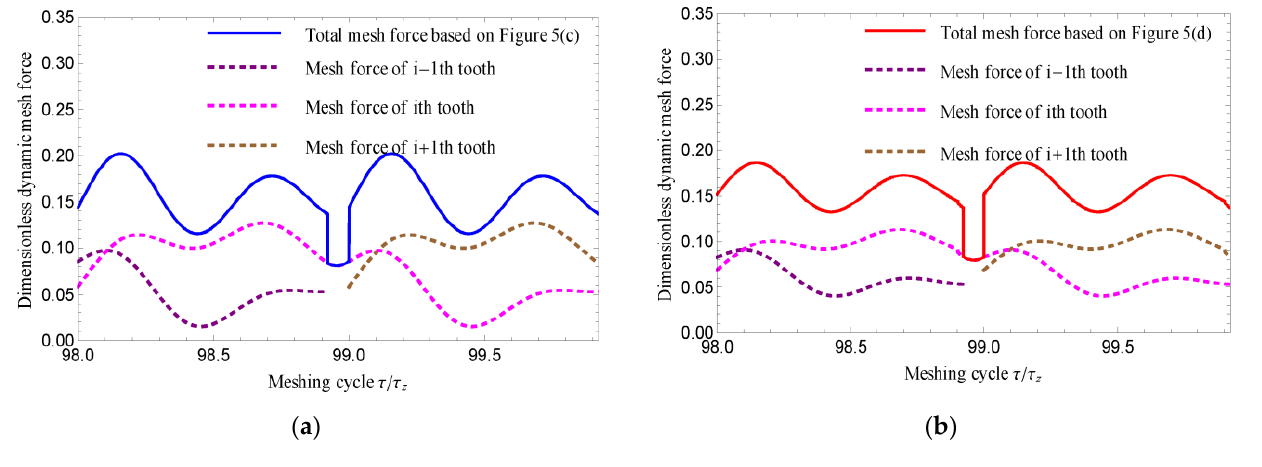
Figure 8. Dynamic mesh force based on new dynamic model under different meshing errors: ( a ) dynamic mesh force based on Figure 5c; ( b ) dynamic mesh force based on Figure 5d.